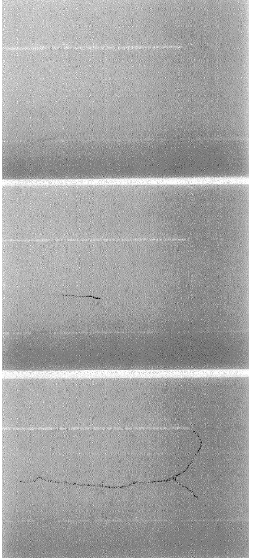
Figure 16. Crack generation and propagation process in a Pb 0.99 Nb 0.02 [(Zr 0.6 Sn 0.4 ) 0.955 Ti 0.045 ] 0.98 O 3 multilayer sample under cyclic electric field application [18]. ( Top )during first field cycle, ( middle ) during the 30 th cycle, ( bottom ) during the 70 th cycle.